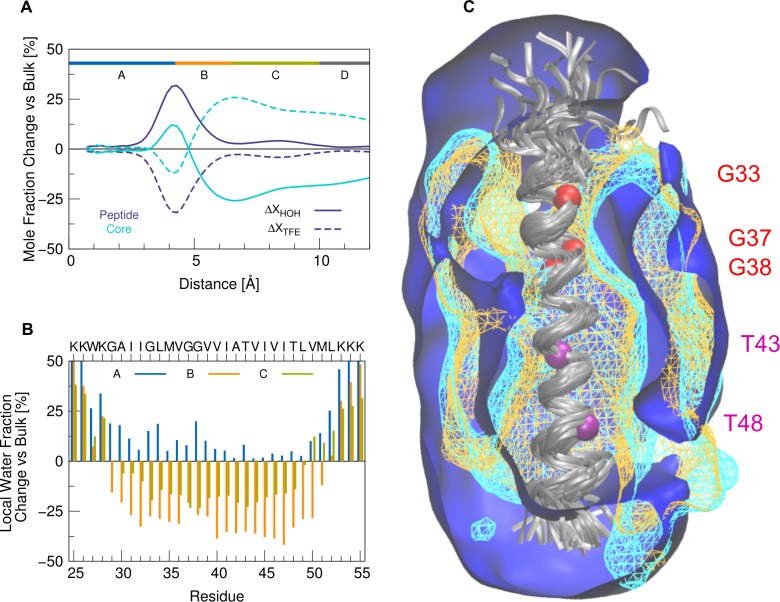
Distribution of solvent around the WT peptide in TFE/water.(A) Mole fraction of water (full lines) and TFE molecules (dashed lines) according to their distance from the peptide. The change is calculated with respect to the bulk values (xHOH (bulk) = xTFE (bulk) = 0.5). Compared is the distribution including all residues (dark blue) with the distribution around the hydrophobic core only (residues A30-V50, light blue). (B) Residue-specific change of the water fraction in three regions (A: r≤4.5 Å, blue; B: 4.5 <r≤ 6.5 Å, orange; C: 6.5 <r≤ 10 Å, green). (C) Contour plots of water (blue) and TFE (orange: hydrophobic part, cyan: hydroxyl group) drawn at a density of 2.3 10−4 molecules/Å3 corresponding to 35% bulk molarity. Data from the last 50 nanoseconds of the simulations were accumulated. The backbone of the peptide (grey) was superimposed onto residues G29-M51 of the average structure. Cα atoms of glycine and threonine residues are indicated by spheres in red and purple, respectively.